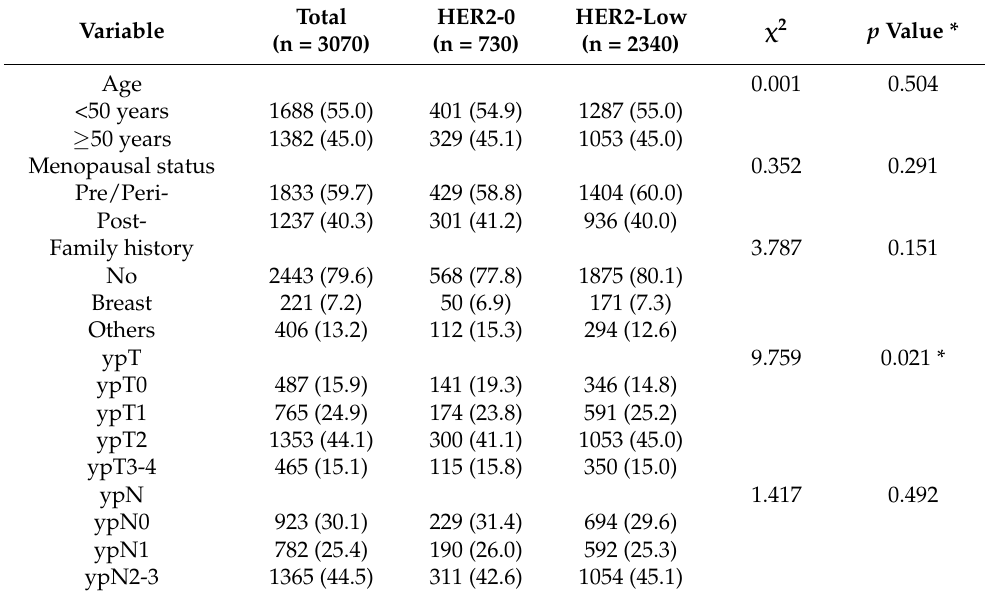
Table 5. Baseline patient characteristics stratified by HER2 status (HER2-zero vs.